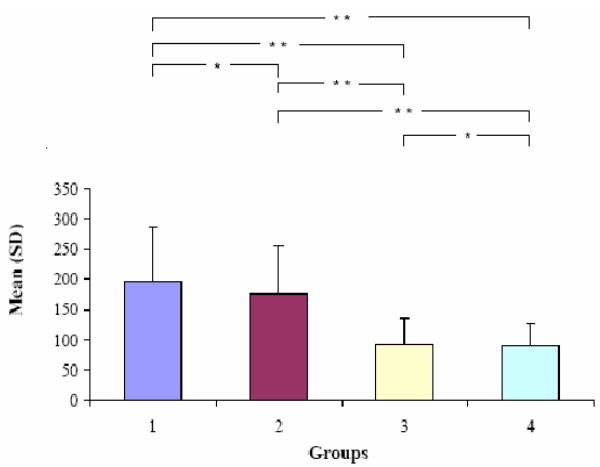
Figure 5: Comparison between completeness indicators (mean ± SD). *, P<0.05; **,